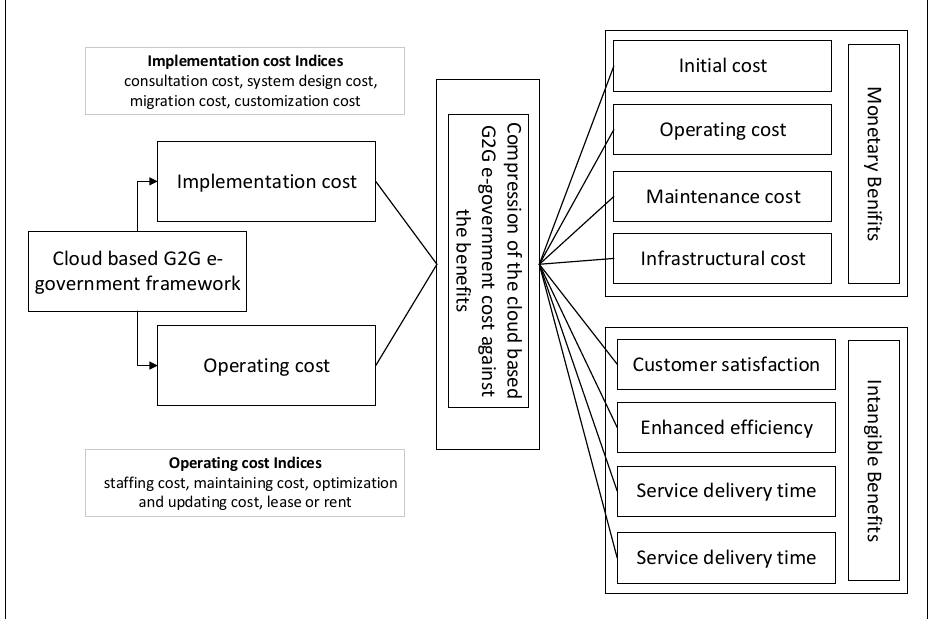
Figure 3. Cost benefit analysis.